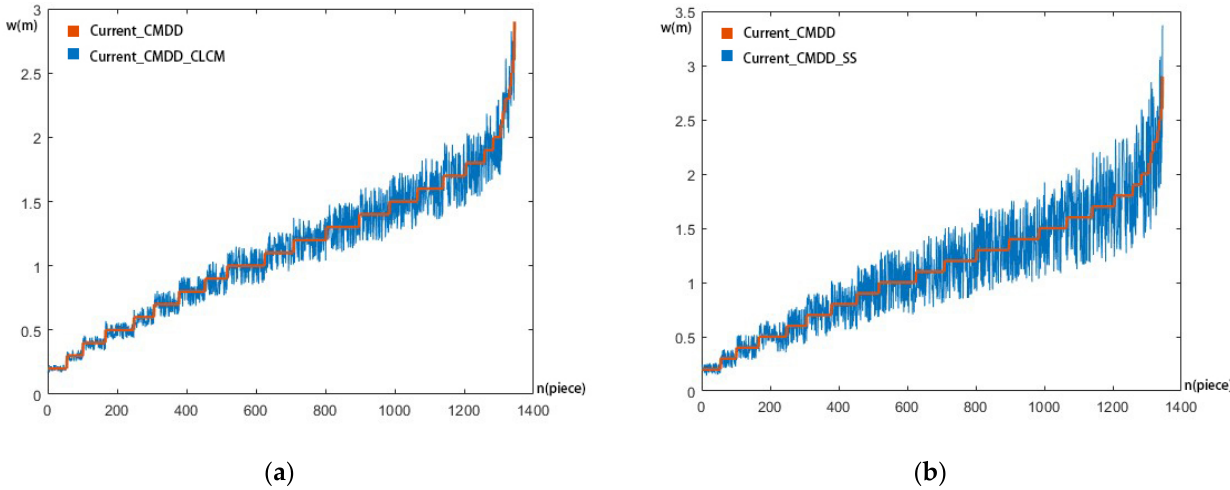
Figure 8. Comparison of canopy width in canopy morphological data: ( a ) Current_CMDD and Current_CMDD_CCLM; ( b ) Current_CMDD and Current_CMDD_SS.